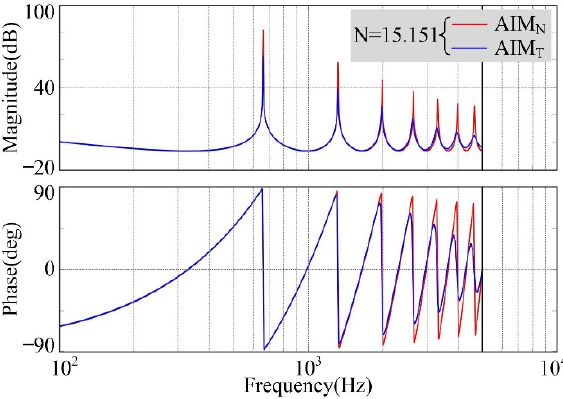
Figure 4. Bode diagrams of adaptive internal mode elements with different decomposition rules.